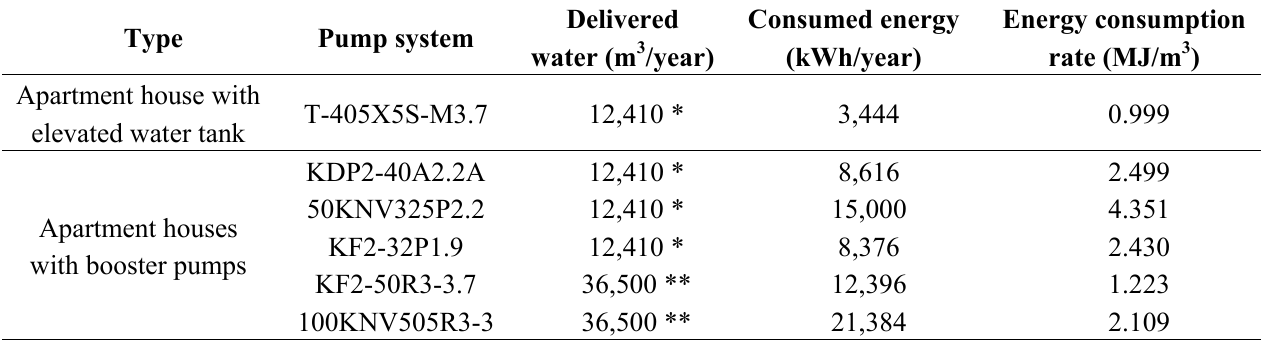
Table 1. Energy consumption for housing pump system in Japan.